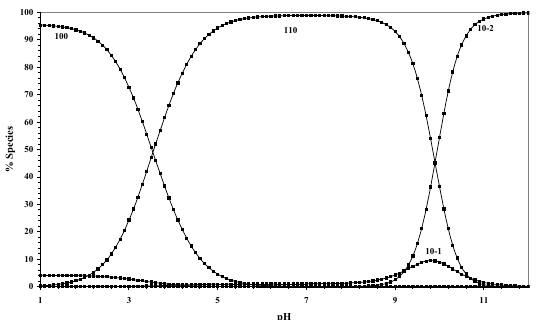
Figure 4. Concentration distribution of various species as a function of pH in the Pd(DAP)-inosine system at concentrations of 1.25×10 -3 mo dm -3 for Pd(DAP) 2+ and inosine, I = 0.1 mol dm -3